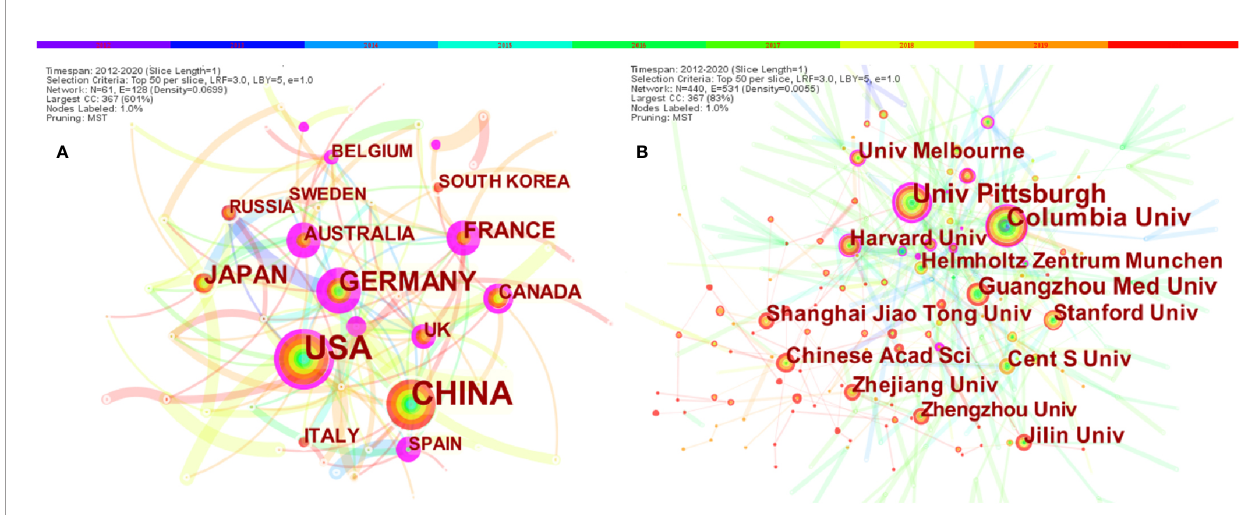
FIGURE 3 | The co-occurrence map of (A) countries/regions and (B) institutions in ferroptosis research (T ≥ 20). Notes: The size of node re fl ects the co-occurrence frequencies, and the links indicate the co-occurrence relationships. The color of node and line represents different years, colors vary from purple to red as time goes from 2012 to 2020; and node with purple round means high betweenness centrality